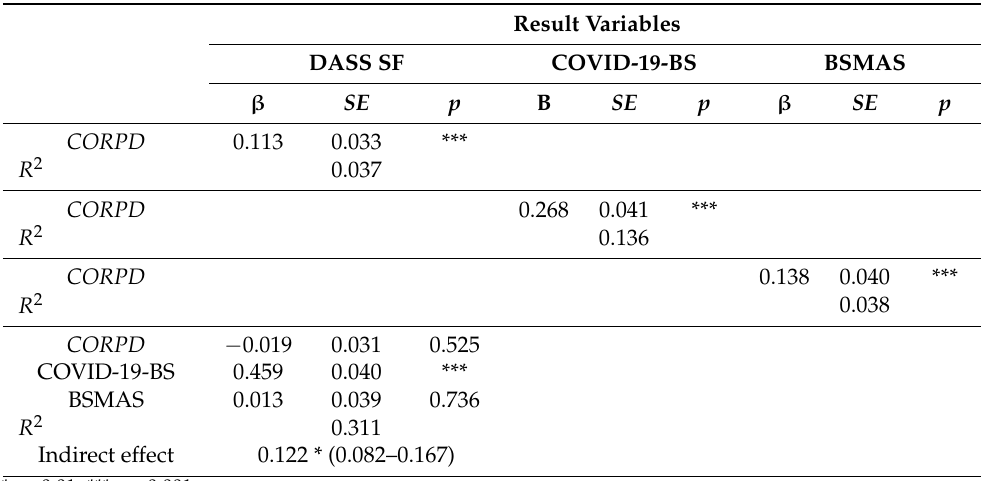
Table 8. Findings on direct and indirect relationships between